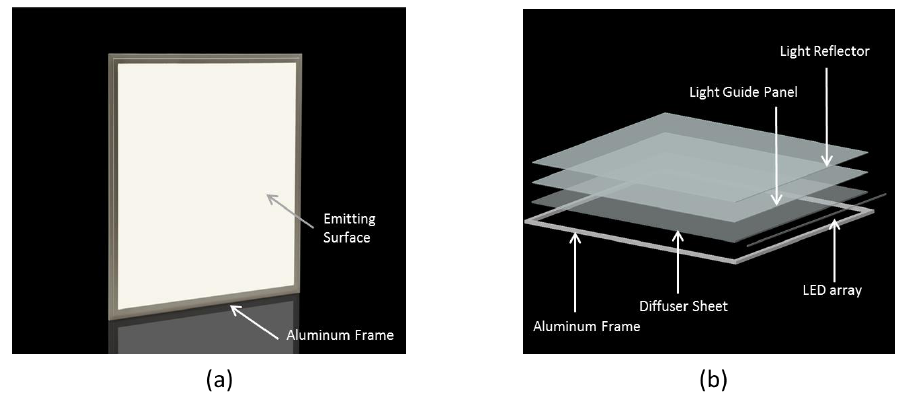
Figure 13. ( a ) Illustration of an LED panel light and ( b ) the dissection of its components